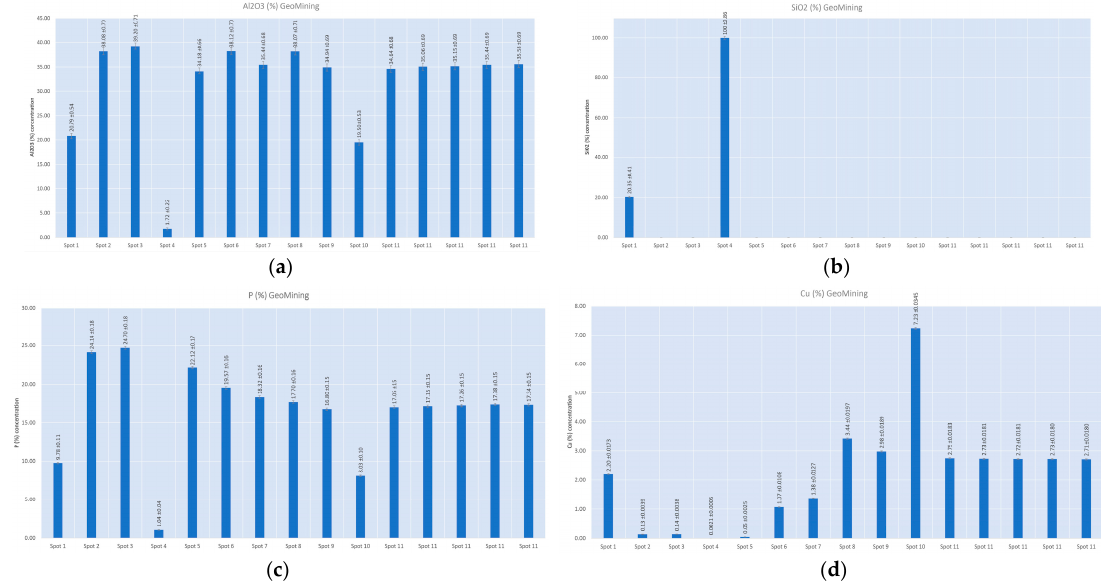
Figure 6. ( a ) Concentration of Al 2 O 3 (wt%) in each spot of the hand sample in GeoMining mode, using the pXRF. ( b ) Concentration of SiO 2 (wt%) in each spot of the hand sample in GeoMining mode, using the pXRF. ( c ) Concentration of P (wt%) in each spot of the hand sample in GeoMining mode, using the pXRF. ( d ) Concentration of Cu (wt%) in each spot of the hand sample in GeoMining mode, using the pXRF.